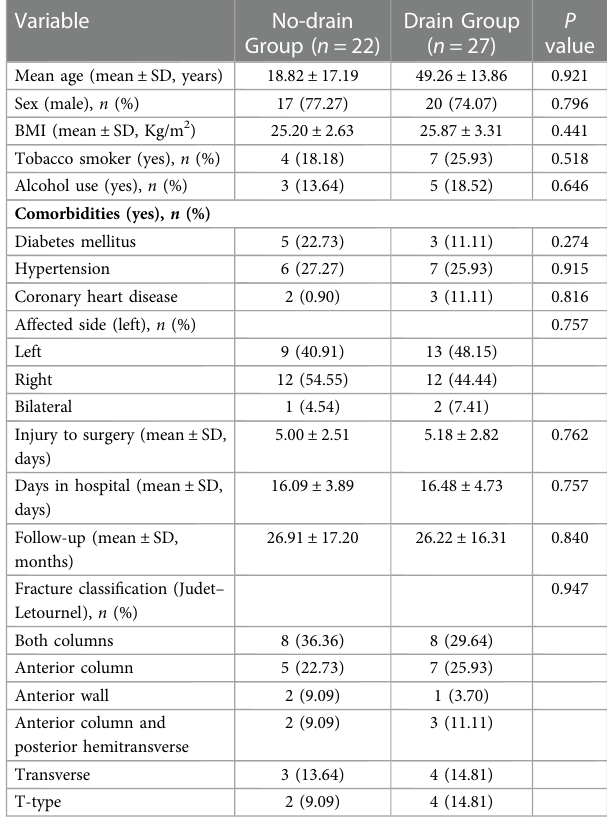
TABLE 1 Patient demographic data and fracture characteristics ( n